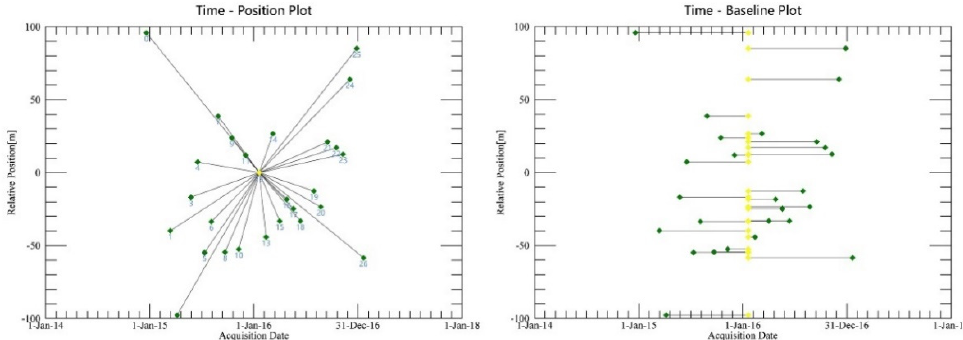
Figure 4. Schematic of the Permanent Scatterer (PS) configuration of the Sentinel-1A images.